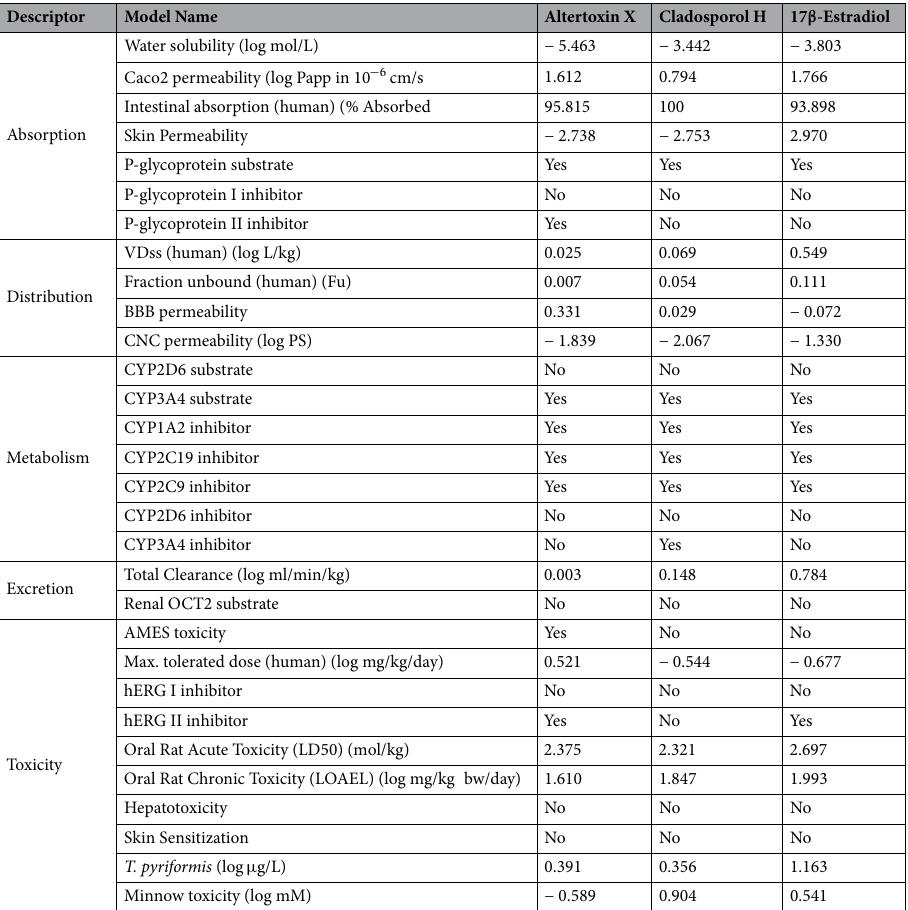
Table 4. Predicted ADMET properties of the selected ligands. Caco-2, Colon cancer cell line; Papp, apparent permeability coefficient; Kp, skin permeability constant; VDss, volume of distribution at steady state; Fu, fraction unbound; BBB, blood-brain-barrier; CBS, central nervous system; PS, permeability-surface area; CYP, Cytochrome P450; AMES, assay of the compounds ability to induce mutations in DNA; hERG, human ether-a- go-ago related gene; LD, lethal dose; LOAEL, lowest observed adverse effect level; T. pyriformis , Tetrahymena pyriformis